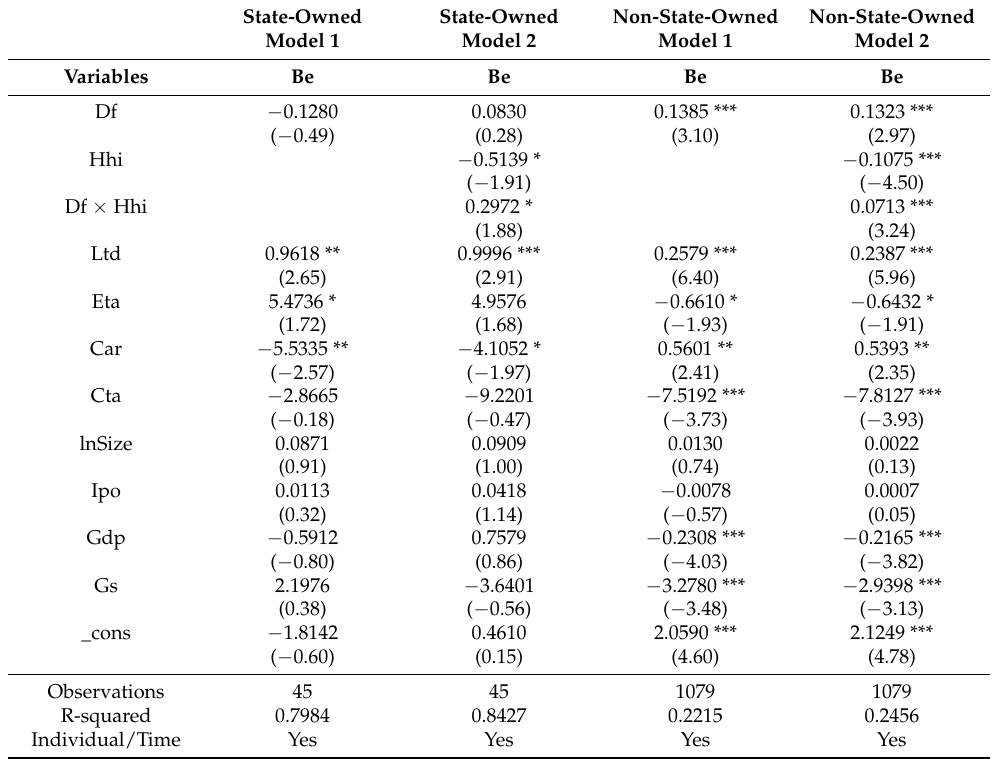
Table 11. Effect of the nature of property